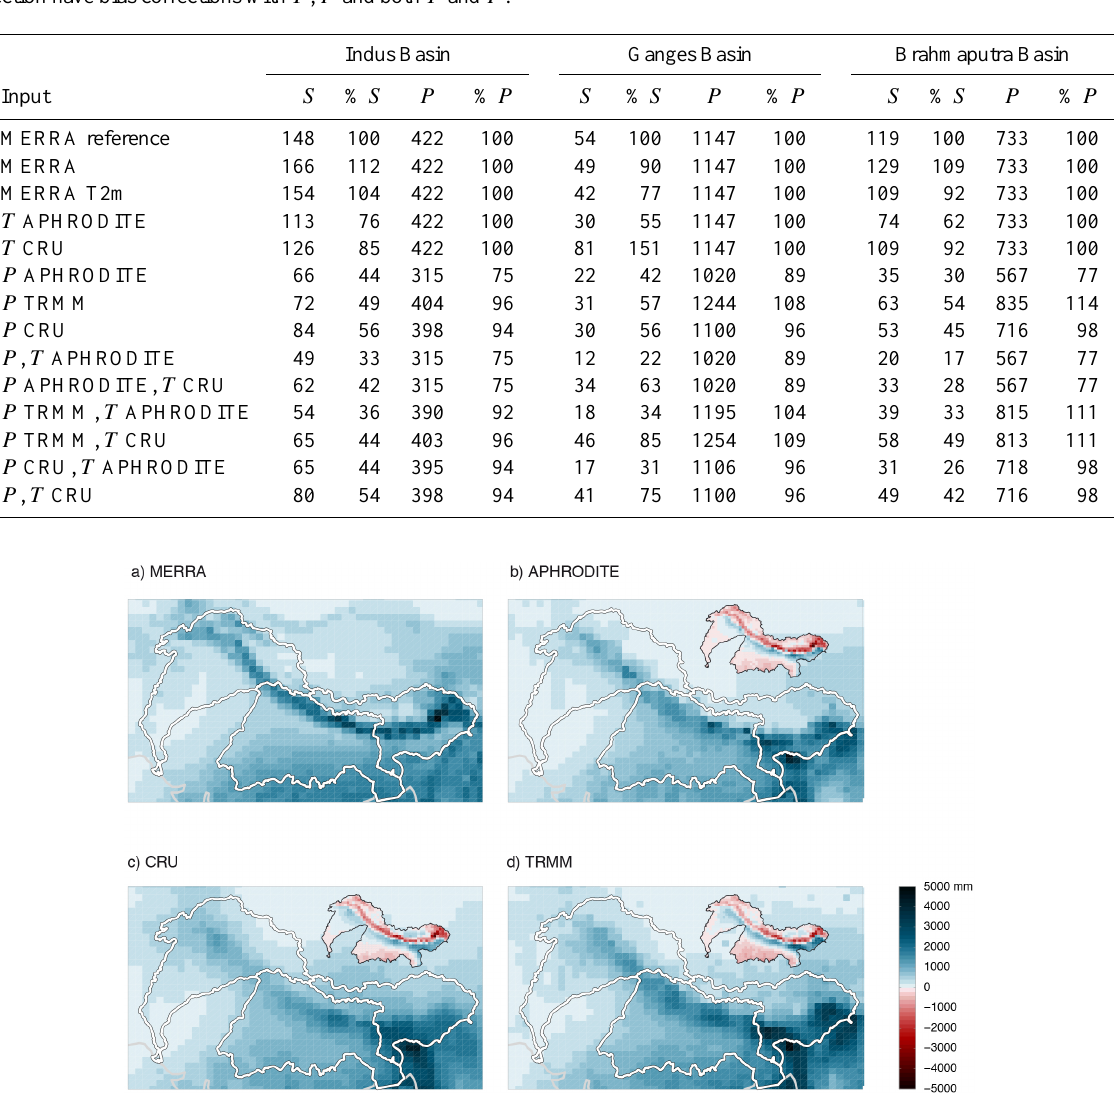
Table 4. Annual snowfall estimates for the Indus, Ganges and Brahmaputra basins. S is snow (km 3 SWE). P is precipitation (km 3 ). % S and % P are percent of MERRA reference snowfall and MERRA precipitation. First horizontal section has no bias corrections. Second, third and fourth section have bias corrections with T , P and both T and P .